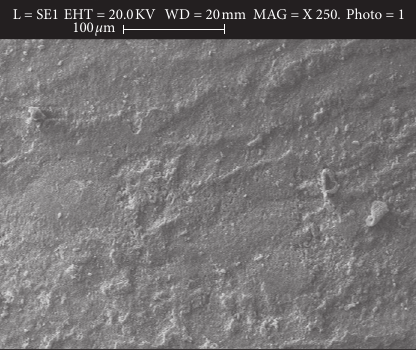
Figure 5: Electro-micrograph showing microporosities with micromechanical retention of adhesive remnants in TM